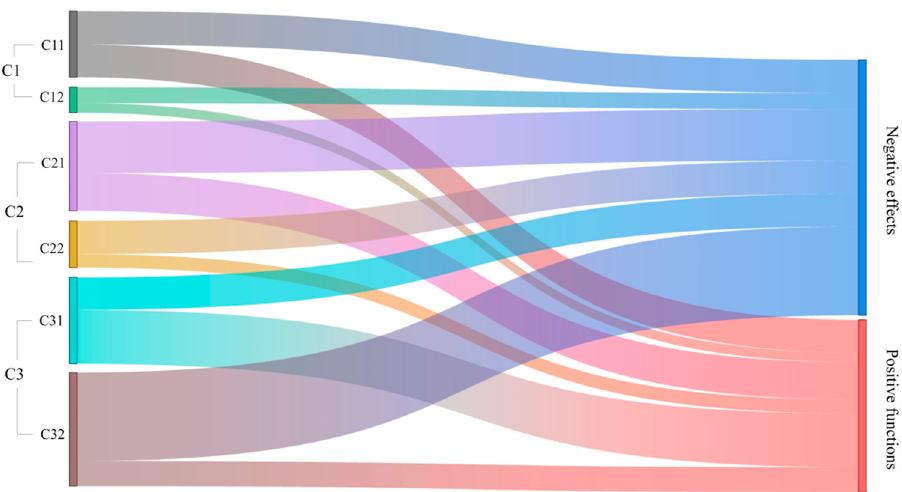
Figure 6. Dual functions based on causes. Source: Authors.